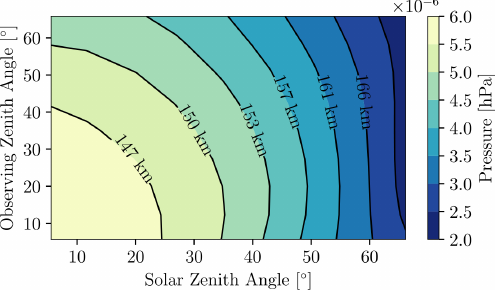
Figure 4. Total T ci random measurement error (not including parti- cle noise) and representativeness error for the (2,0) band. The range of (2,0) band counts for GOLD data (250 × 250km resolution at nadir) used in the case study in Sect. 4 is highlighted by the gray box.